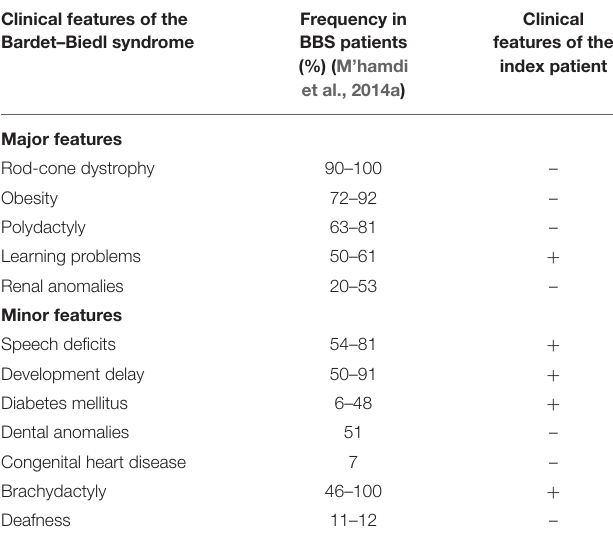
TABLE 3 | Comparison of the clinical features of the patient with those of the Bardet–Biedl syndrome. Clinical features of the Bardet–Biedl